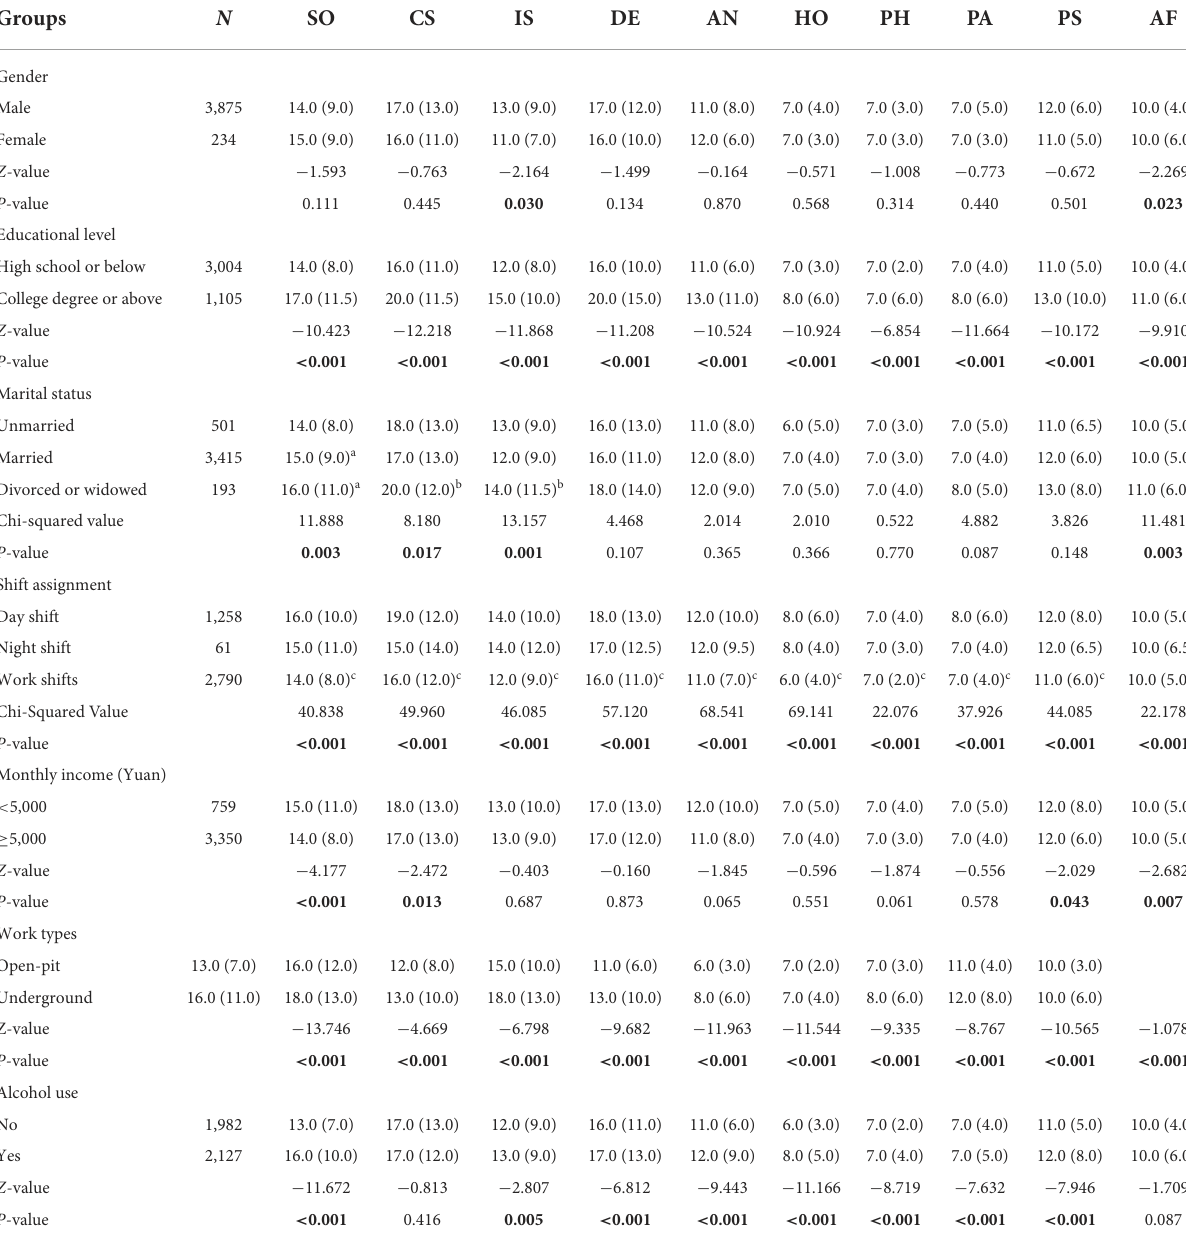
TABLE 2 Comparison of SCL-90 dimensions score among different sub-groups [ M ( Q R )].